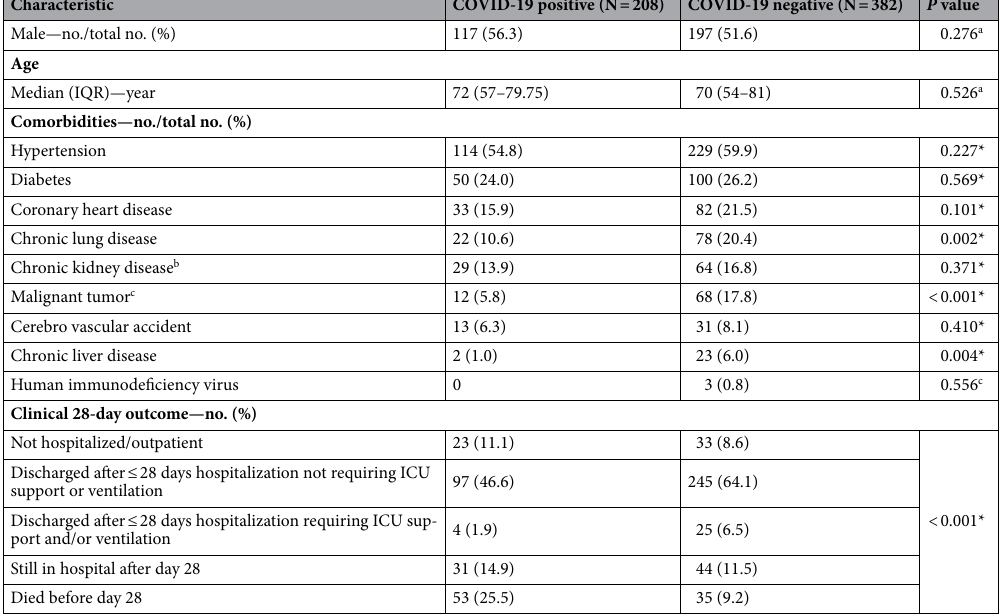
Table 1. Comparison of demographic characteristics and 28-day clinical outcome between COVID-19 positive and negative tested patients. Abbreviation: COVID-19 coronavirus disease 2019, ICU intensive care